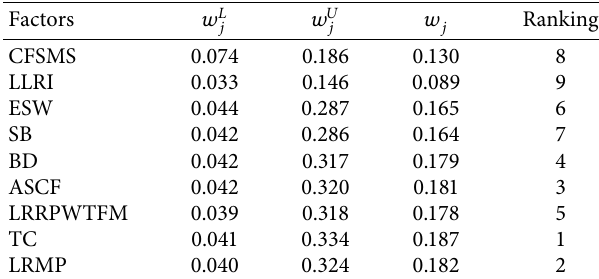
Table 3: Te rough SWARA fndings.